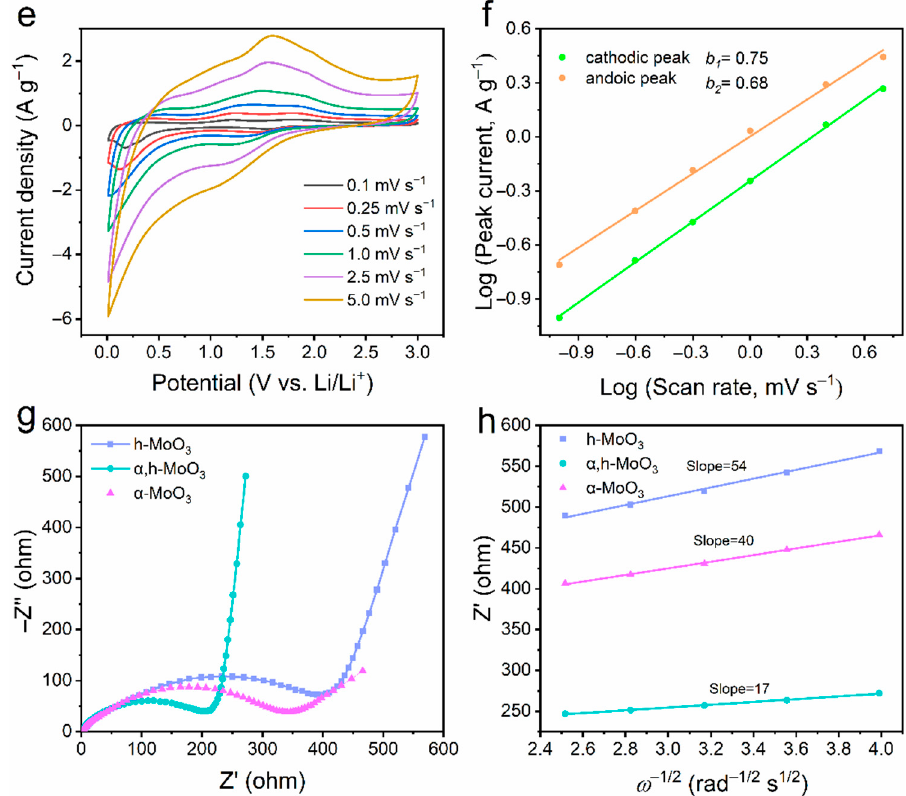
Figure 4. The CV curves at different scan rates and corresponding b -value determinations of ( a , b ) Sample B: α /h-MoO 3 , ( c , d ) Sample A: h-MoO 3 , and ( e , f ) Sample C: α -MoO 3 . ( g ) Electrochemical impedance spectra and ( h ) Z ′− ω − 1/2 plots.